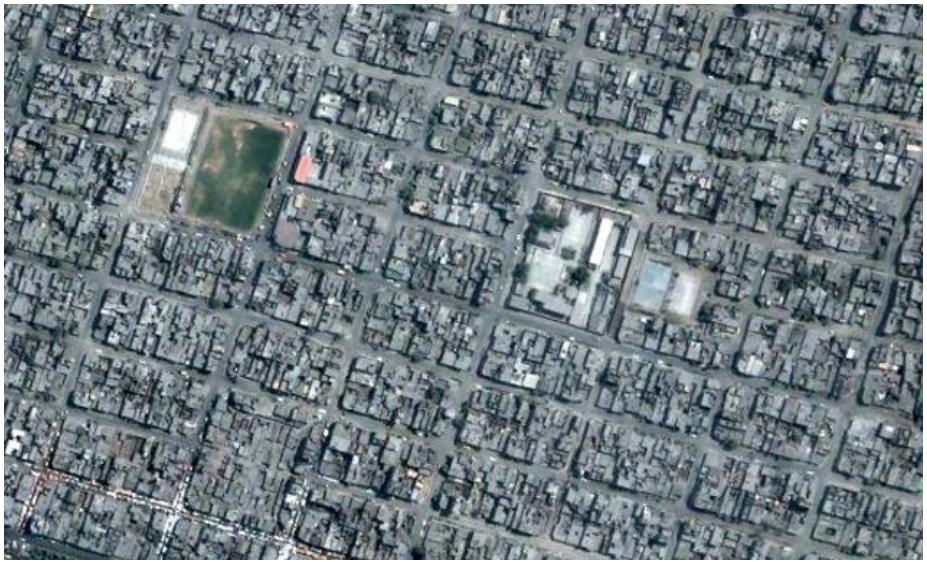
Figure 3. The streets in the Comás squatter community in Lima, Peru, are 10-meters-wide and take up 25% of the area. A 160m 2 house there now costs $180,000. Source: Google